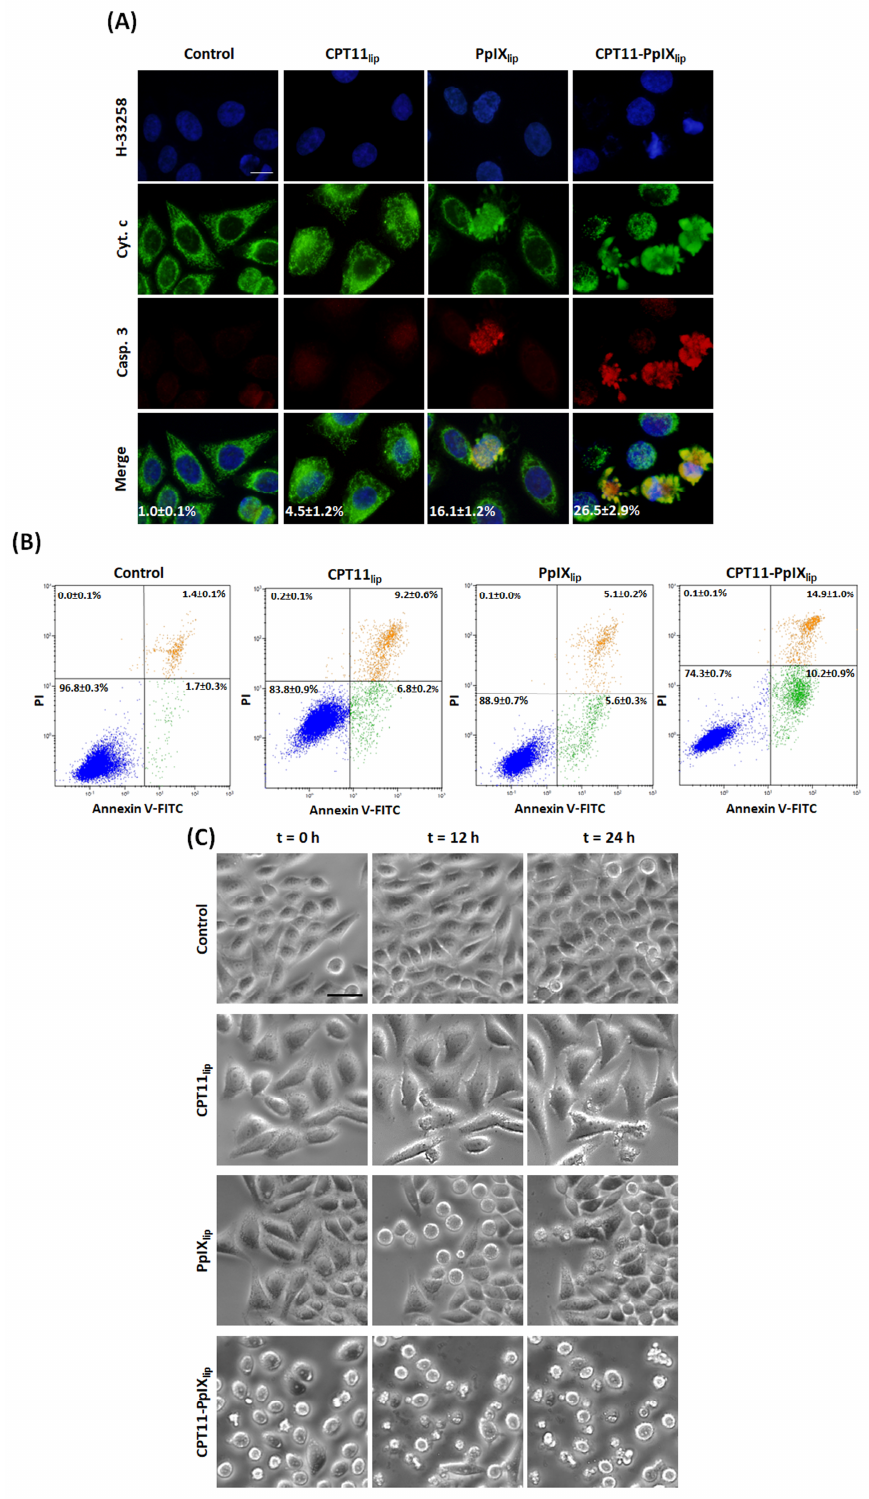
Figure 3. Analysisofapoptotic HeLacelldeath. ( A